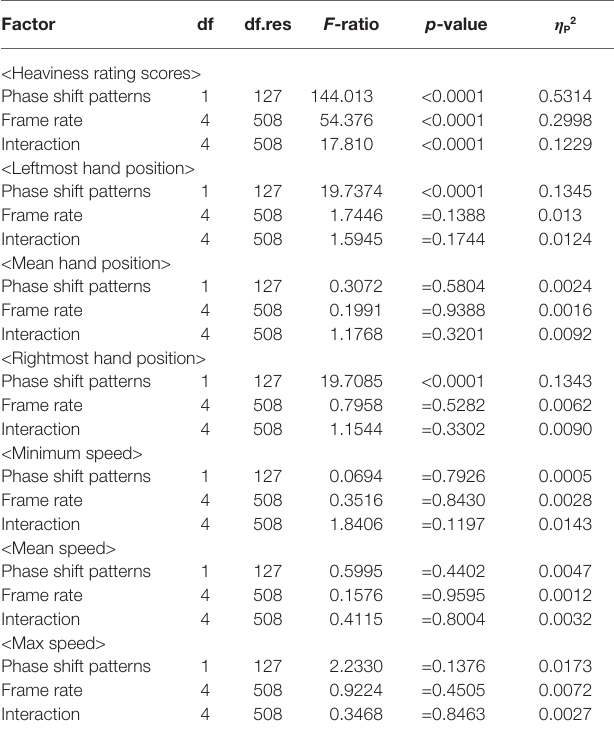
TABLE 2 | ANOVA Table for the results of Experiment